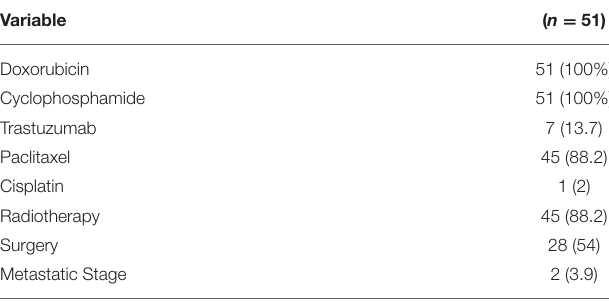
TABLE 2 | Cancer treatment and metastatic